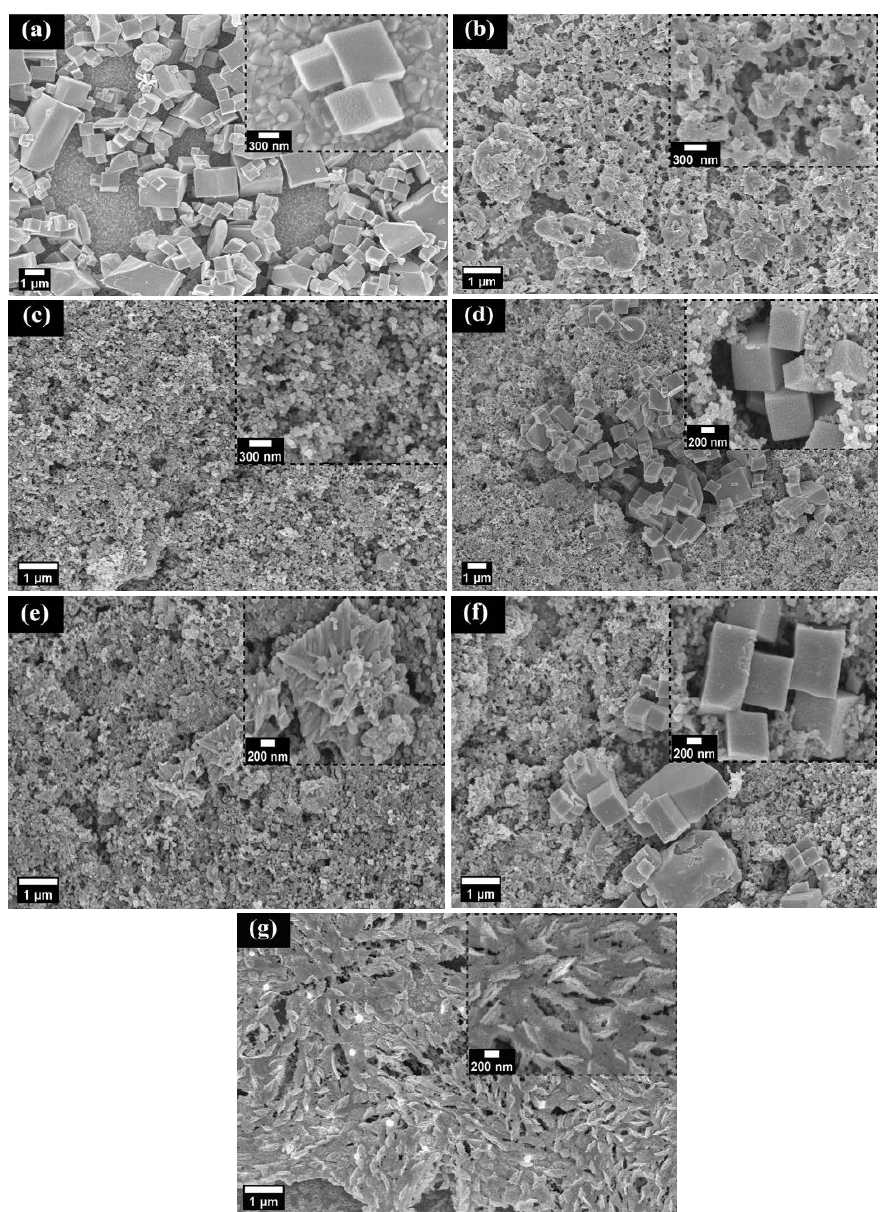
Figure 1. Typical SEM images of FTO/L ( a ), FTO/F ( b ), FTO/CB ( c ), and FTO/L@CB ( d ), FTO/F@CB